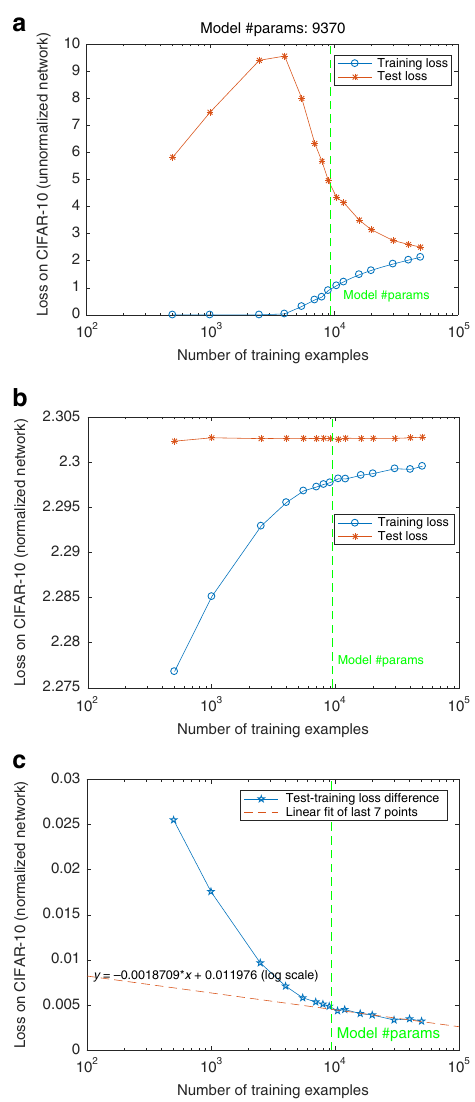
Fig. 1 Classical generalization and consistency in deep networks. a Unnormalized cross-entropy loss in CIFAR-10 for randomly labeled data. b Cross-entropy loss for the normalized network for randomly labeled data. c Generalization cross-entropy loss (difference between training and testing loss) for the normalized network for randomly labeled data as a function of the number of data N . The generalization loss converges to zero as a function of N but very